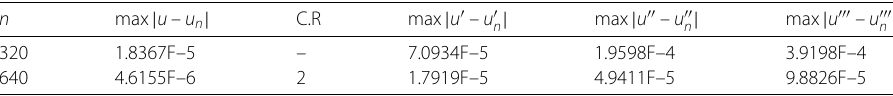
Figure 4 u (cid:2) n ( x ) and u (cid:2) ( x )